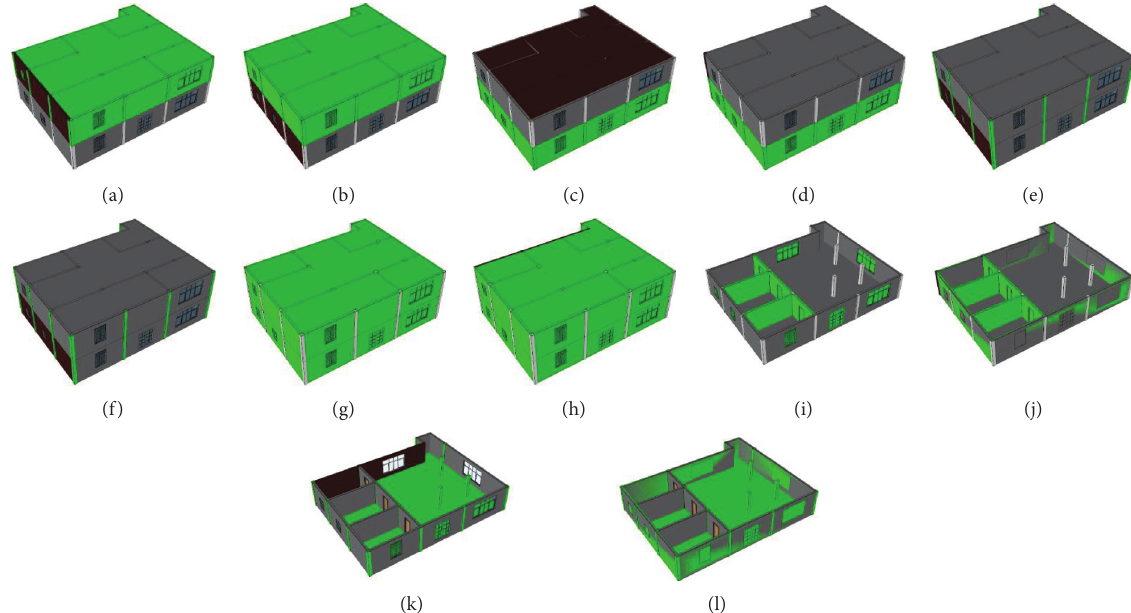
Figure 14: Display of the merged IFC model. (a) Revit-a-b. (b) Revit-a-b (GUID). (c) ArchiCAD-a-b. (d) ArchiCAD-a-b (GUID). (e) Revit- c-d. (f) Revit-c-d (GUID). (g) ArchiCAD-c-d. (h) ArchiCAD-c-d (GUID). (i) Revit-e-f. (j) Revit-e-f (GUID). (k) ArchiCAD-e-f. (l) ArchiCAD-e-f